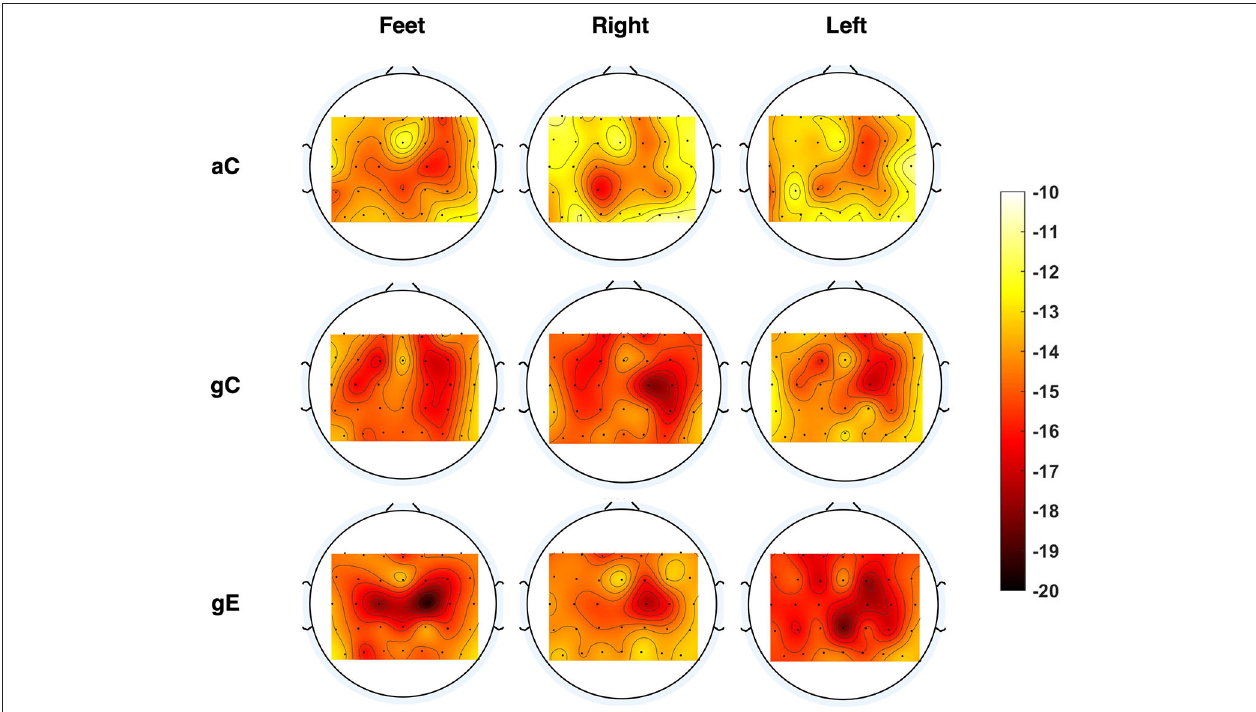
FIGURE 8 | Evolution of brain activity. Topoplots showing brain activation patterns computed as the relative power (in dB) in the mu band (8–12 Hz) for the arrow-based calibration ( aC ), game-based calibration ( gC ), and the online games ( gE ) for Session 17 for the pilot in phase II.